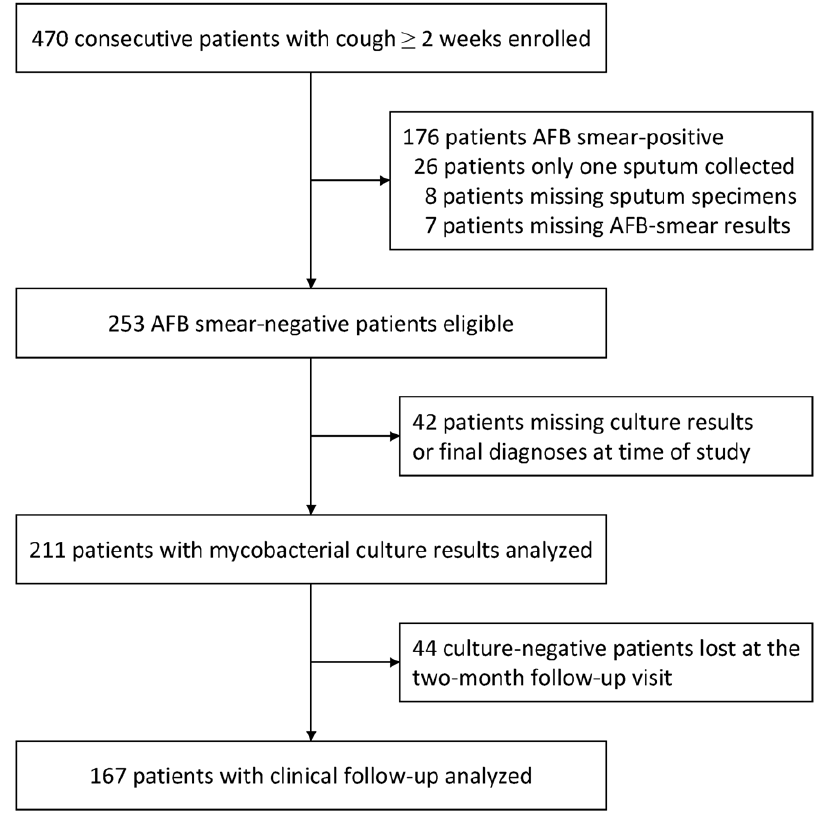
Figure 1. Patients enrolled, eligible, and analyzed.